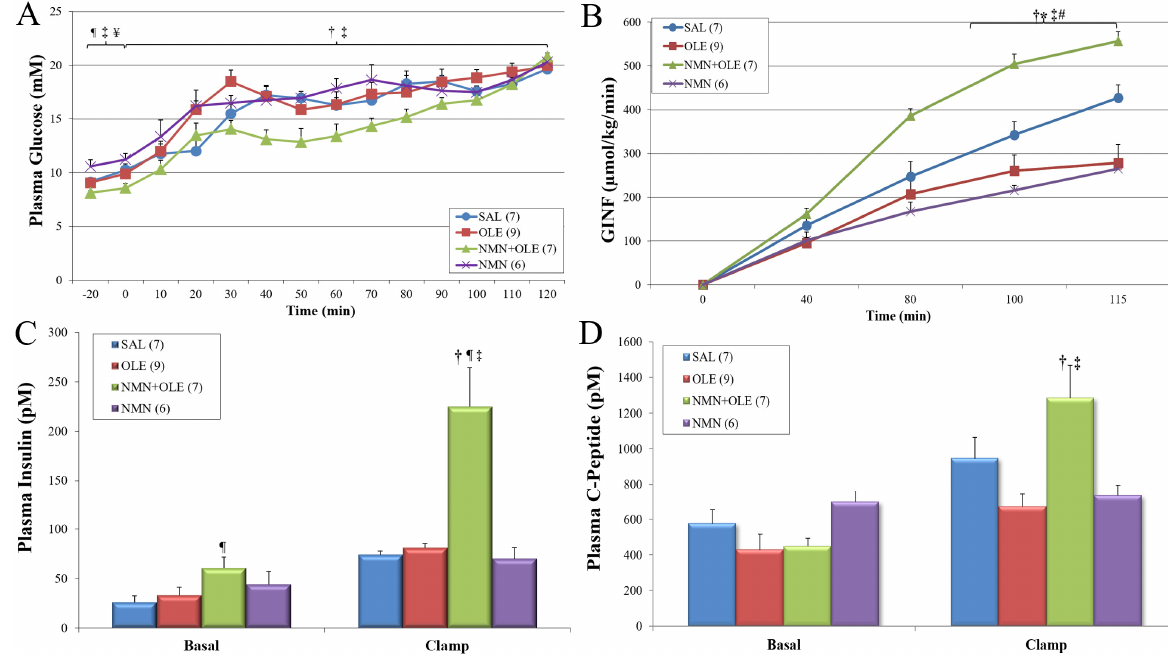
Figure 1. ( A ) Plasma glucose levels in mice infused intravenously with 37.5% glucose during hyperglycemic clamp. ( B ) Glucose infusion rate (GINF) required to obtain and maintain hyperglycemia. ( C ) Plasma insulin levels and ( D ) Plasma C-peptide levels prior to intravenous glucose infusion (basal period) and during the last 30 min of the clamp. C57BL/6J mice were intravenously infused for 48 h with SAL, OLE (0.4 μ mol/min), NMN (0.025 mg·kg − 1 ·min − 1 ) + OLE, or NMN alone. These infusions were maintained during the hyperglycemic clamp. Data are means ± SE. Number in parentheses represents number of animals. * p < 0.05, SAL vs. OLE; ¶ p < 0.05, SAL vs. NMN + OLE; # p < 0.05, SAL vs. NMN; † p < 0.05, OLE vs. NMN + OLE; ‡ p < 0.05, NMN + OLE vs. NMN; ¥ p < 0.05, OLE vs. NMN.